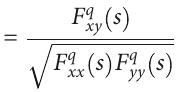
Figure 1. For both these indices, the fl uctuation functions F q , s reveal a convincing power-law behaviour over almost two decades, which is shown in the corresponding lower- right insets; thus, f α is determined unambiguously. The parameters q are taken within the interval − 4 ≤ q ≤ 4 , which is common in fi nancial applications because it allows to safely avoid the danger of divergent moments when the fl uc- tuation functions F q , s are computed. Cumulative